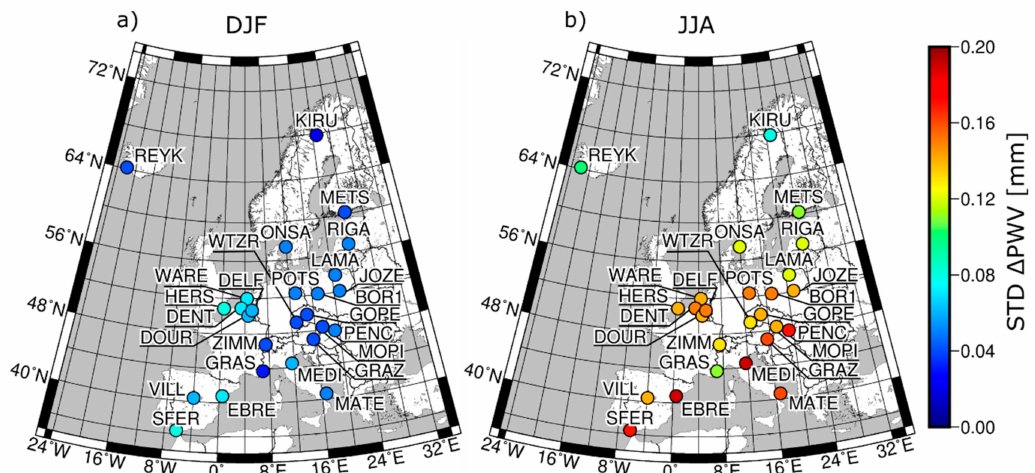
Figure 9. Standard deviations of di ff erences between global navigation satellite system (GNSS) PWV values estimated using Bevis and ETmPoly coe ffi cients for the seasons: ( a ) December / January / February (DJA) and ( b ) June / July / August